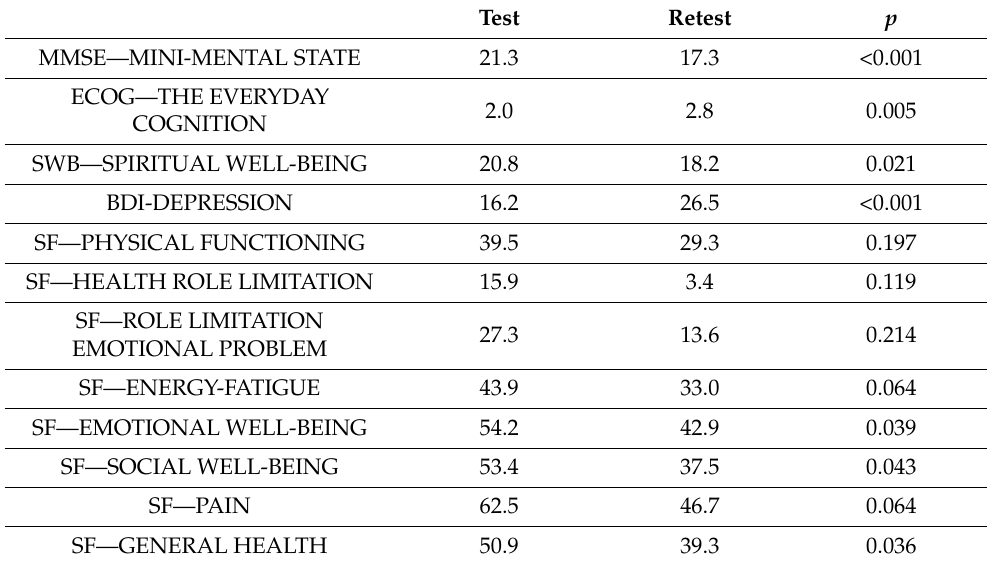
Table 3. Untreated patients: Evaluation of quality of life, depression, and MMSE (T0–T1 six